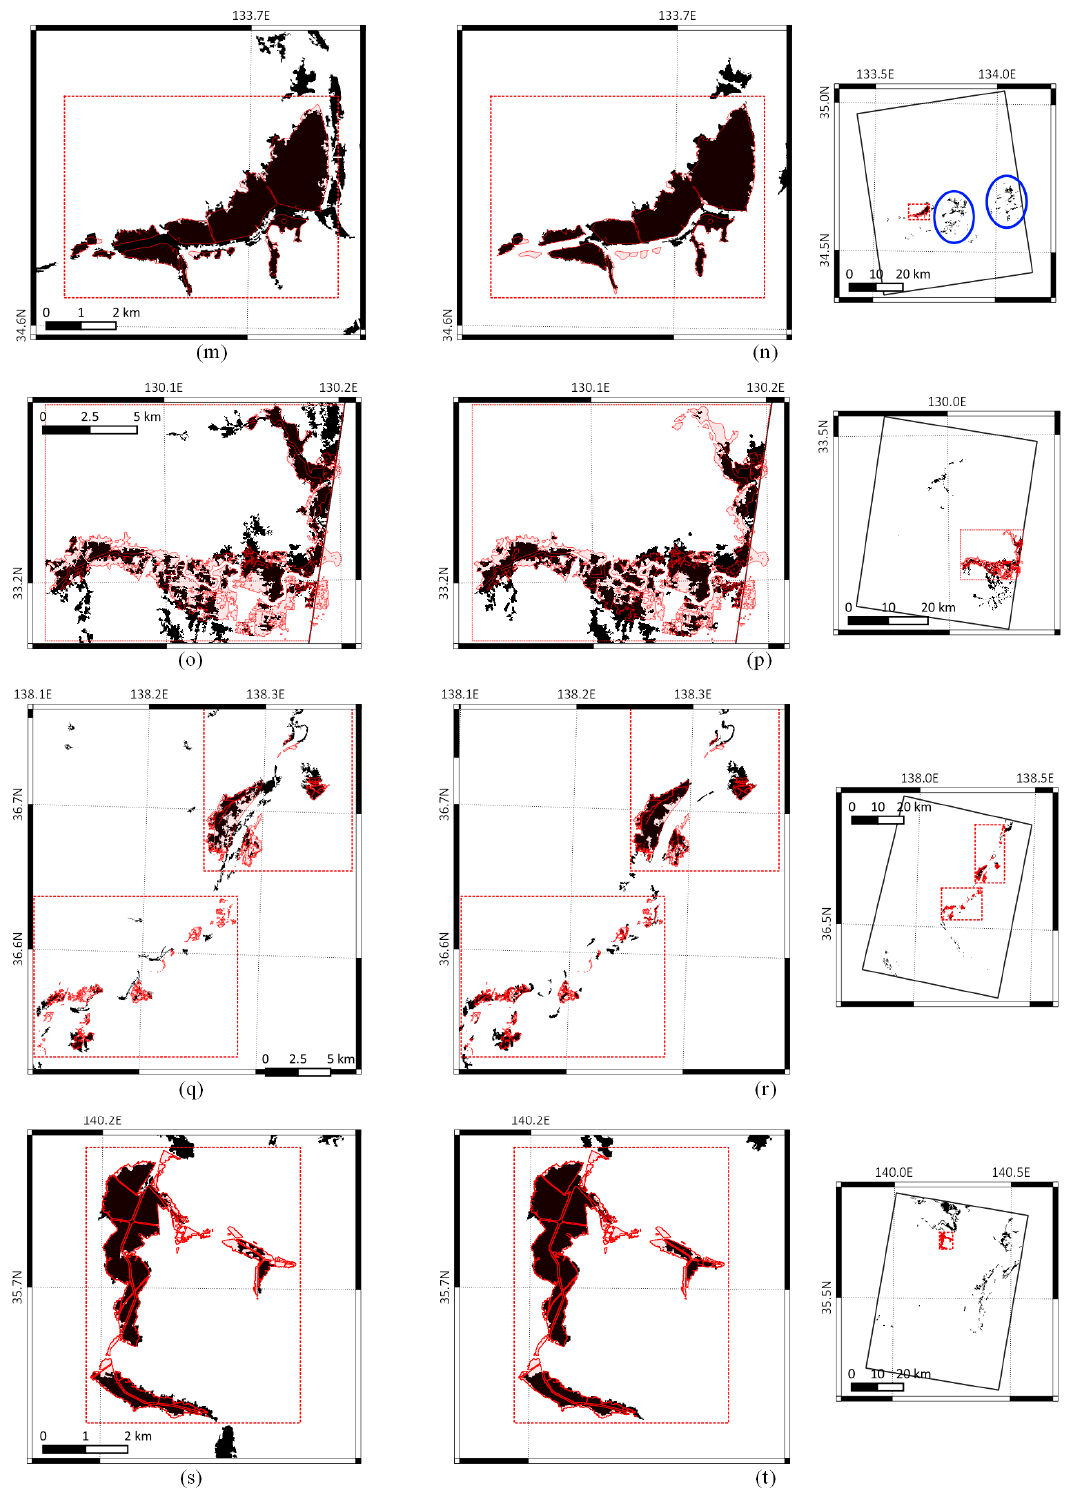
Figure 7. Flood areas obtained from ALOS-2 data with and without flood simulation (black solid polygon), compared with the reference data (red line polygon); ( a , b ) show flooding in Joso on 11 September 2015, (case 1), ( c , d ) on September 12 (case 2), ( e , f ) on September 13 (case 3), ( g , h ) on September 14 (case 4), ( i , j ) on September 16 (case 5), ( k , l ) flooding in Kitami on 22 August 2016, (case 6), ( m , n ) flooding in Mabi on 8 July 2018, (case 7), ( o , p ) flooding in Saga on 28 August 2019, (case 9), ( q , r ) flooding in Chikuma on 13 October 2019, (case 10), ( s , t ) flooding in Chiba on 14 September 2019, (case 12). The left ( a , c , e ... ) and right figures ( b , d , f ... ) represent results using and not using flood simulation,